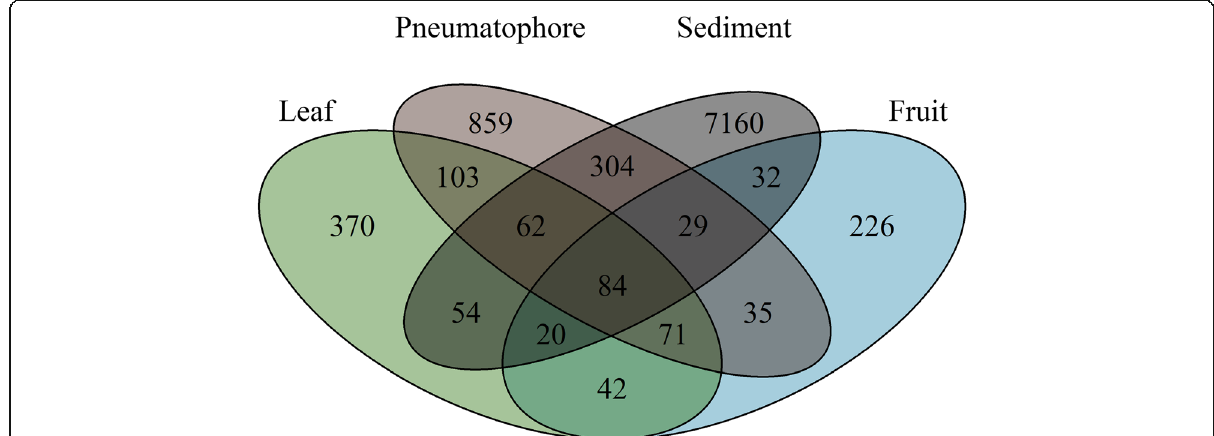
Fig. 4 Venn diagram illustrating the number of amplicon sequence variants (ASVs) unique to each sampled part, and those shared between parts, showing that sediment has the highest fungal richness and 84 ASVs are shared between all sampled